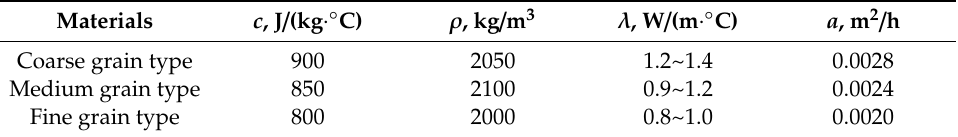
Table 2. Thermophysical parameters.